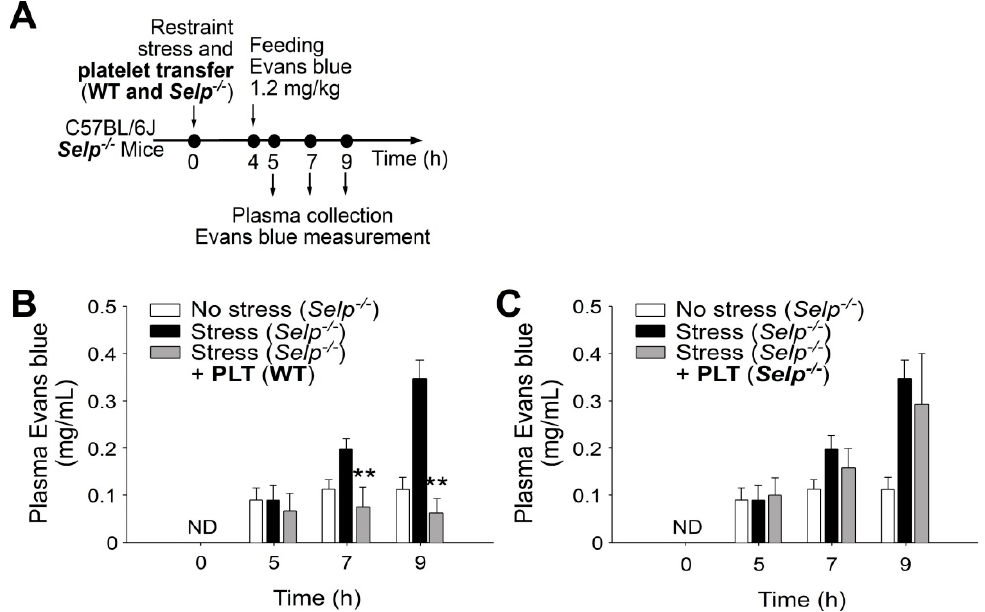
Figure 4. Transfer of wild-type (WT) washed platelets rescues stress-induced gut leakage in P-selectin-deficient ( Selp − / − ) mice. ( A ) Experiment outline of restraint stress mouse model with Evans blue treatment. ( B ) Plasma Evans blue levels of Selp − / − mice without restraint stress (no stress) and with stress [stress ( Selp − / − )] and stressed Selp − / − mice transferred with wild-type platelets [stress ( Selp − / − ) + PLT (WT)] at 0, 5, 7, and 9 h. ND: not detected. ( C ) Plasma Evans blue levels of mice without restraint stress (no stress) and with stress (stress) and stressed wild-type mice transferred with platelets derived from Selp − / − mice [stress ( Selp − / − ) + PLT ( Selp − / − )] at 0, 5, 7, and 9 h. ND: not detected. ** p < 0.01, vs. respective stress groups. n = 6 (three experiments with total six mice per